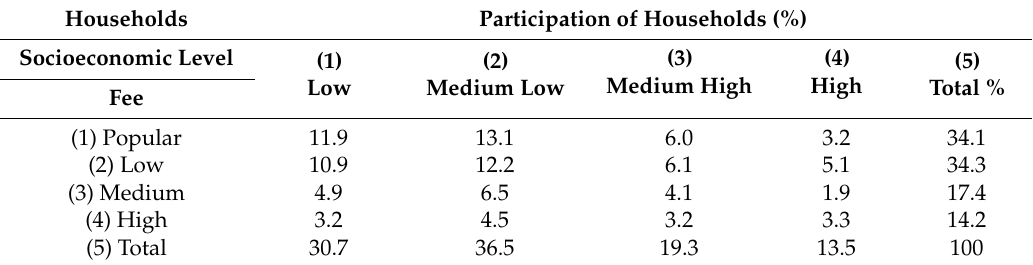
Table 4. Distribution of households using drinking water by socioeconomic income level and type of fee in